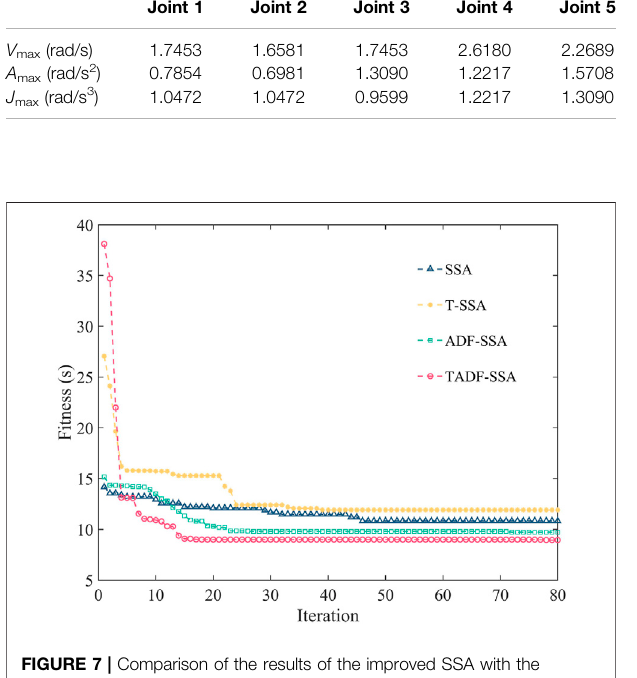
FIGURE 7 | Comparison of the results of the improved SSA with the original algorithm.